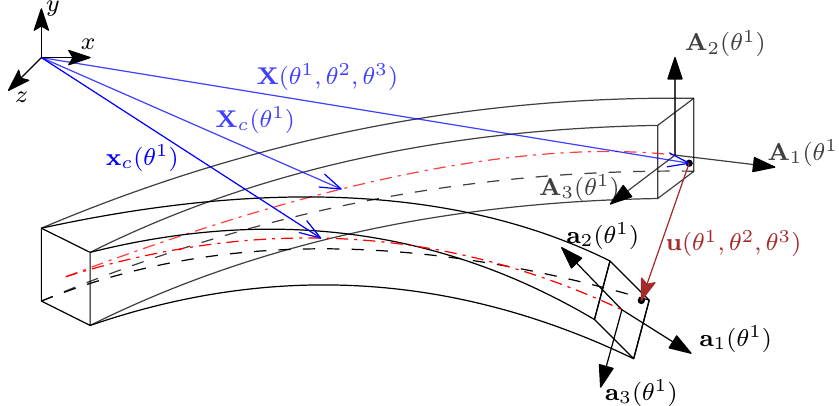
Figure 2. Illustration of the Bernoulli beam in its undeformed and deformed configurations.